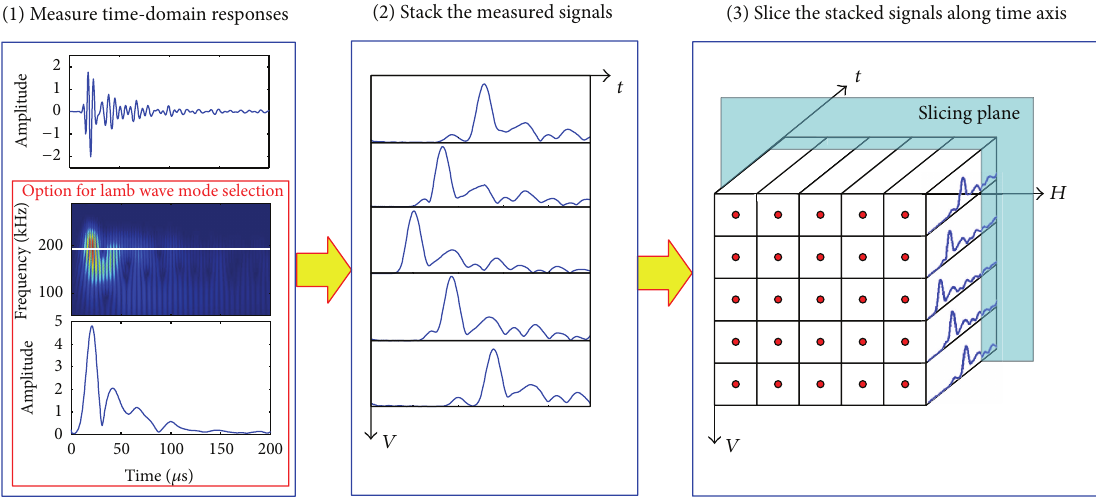
Figure 2: A scheme of an ultrasonic wave propagation imaging algorithm.